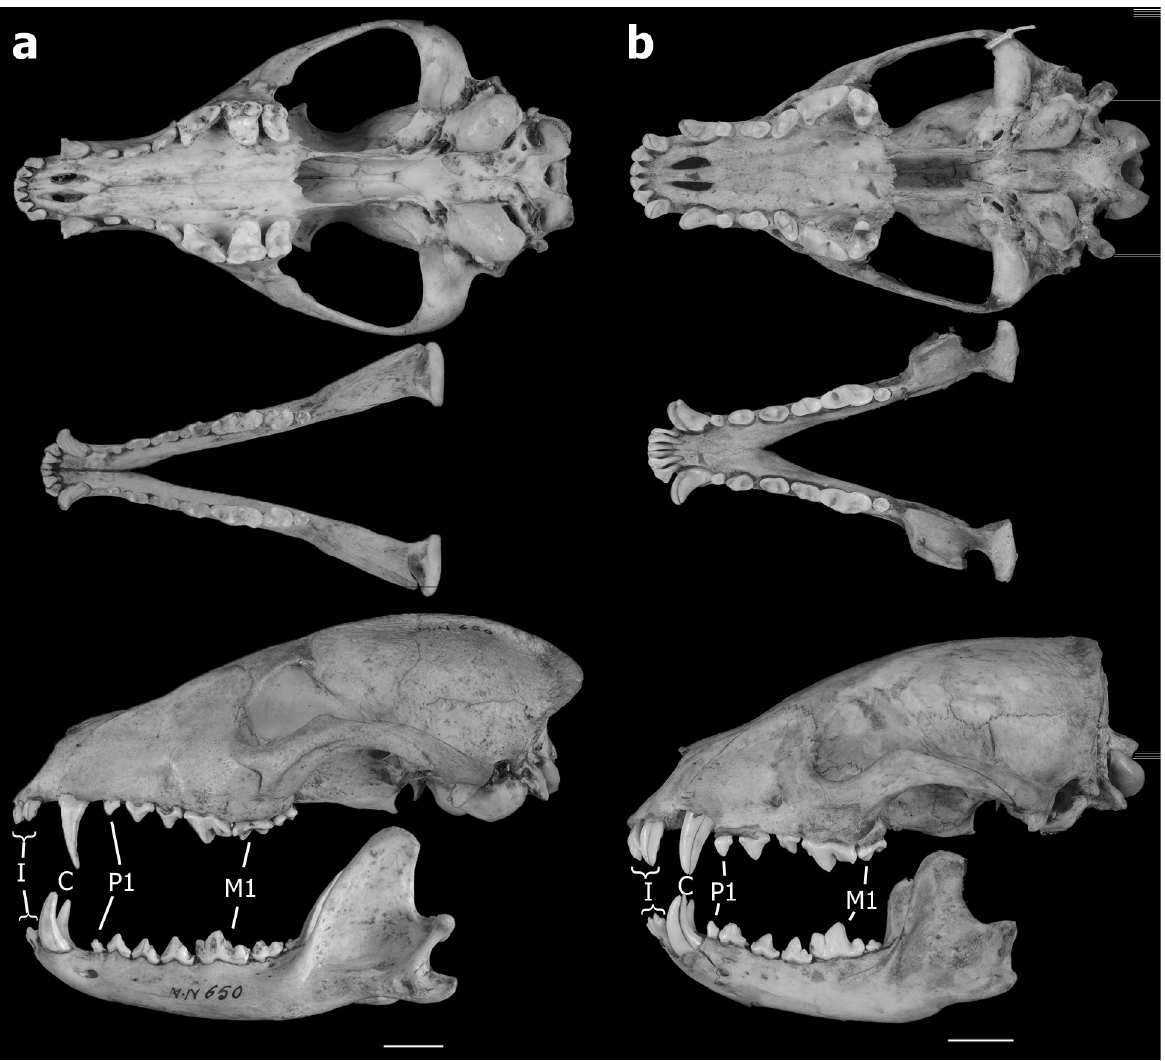
Figure 1. Occlusal (top) and lateral (bottom) views of the skull and mandible of: a) Atelocynus microtis (MN650); b) Speothos venaticus (MN25670). Abbreviation “I” means incisors, “C” canines, “P” premolars and “M” molars. Scale bar =